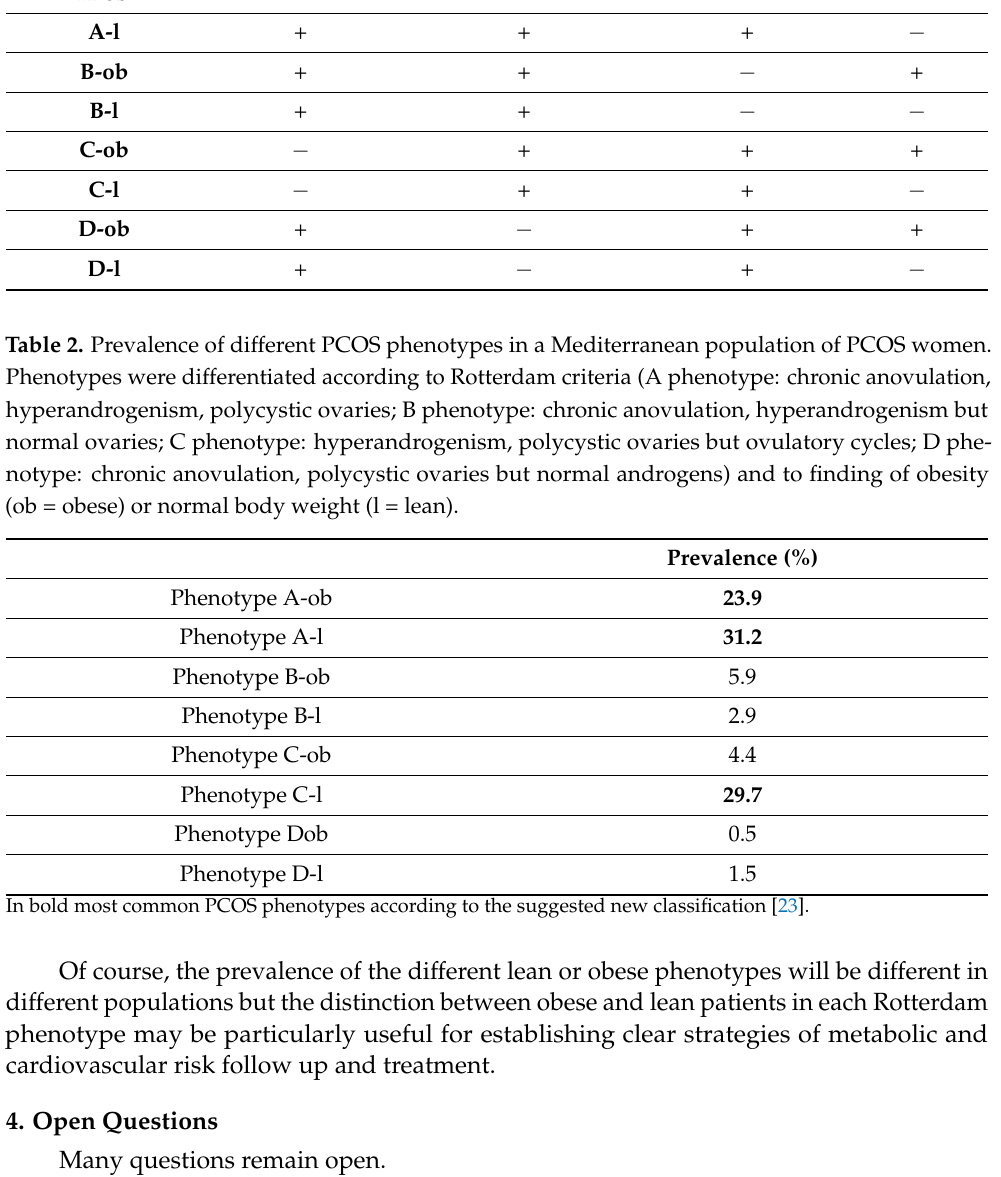
Table 1. Suggested new classification of PCOS. Phenotypes were differentiated according to Rotter- dam criteria (A phenotype: chronic anovulation, hyperandrogenism, polycystic ovaries; B phenotype: chronic anovulation, hyperandrogenism but normal ovaries; C phenotype: hyperandrogenism, poly- cystic ovaries but ovulatory cycles; D phenotype: chronic anovulation, polycystic ovaries but normal androgens) and to finding of obesity (ob = obese) or normal body weight (l = lean).